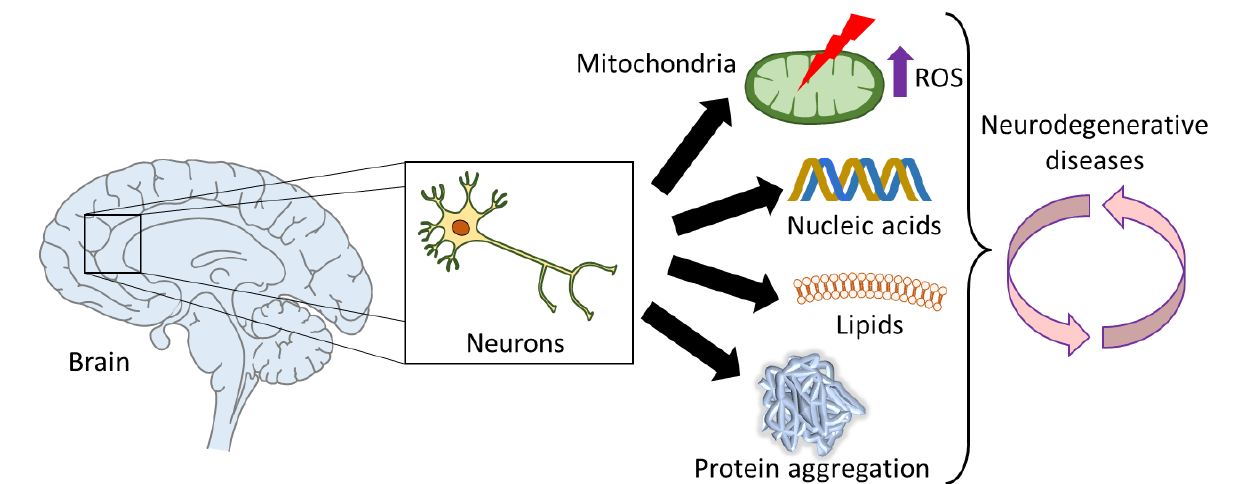
Figure 7. Graphical summary of the association of oxidative stress in neurodegenerative diseases. Neurons in the brain can suffer deleterious modifications due to high levels of ROS. These ROS can be mitochondrial-generated, for instance due to mitochondrial dysfunction, and further contribute to increasing the mitochondrial damage, since ROS can also oxidize DNA, RNA and lipids. Furthermore, protein aggregation is partly caused by ROS, and subsequently, promotes oxidative stress. All these hallmarks of oxidative stress are well-established and may play a role in many age-related neurodegenerative diseases, such as Alzheimer’s, Parkinson’s and Huntington’s dis- eases.